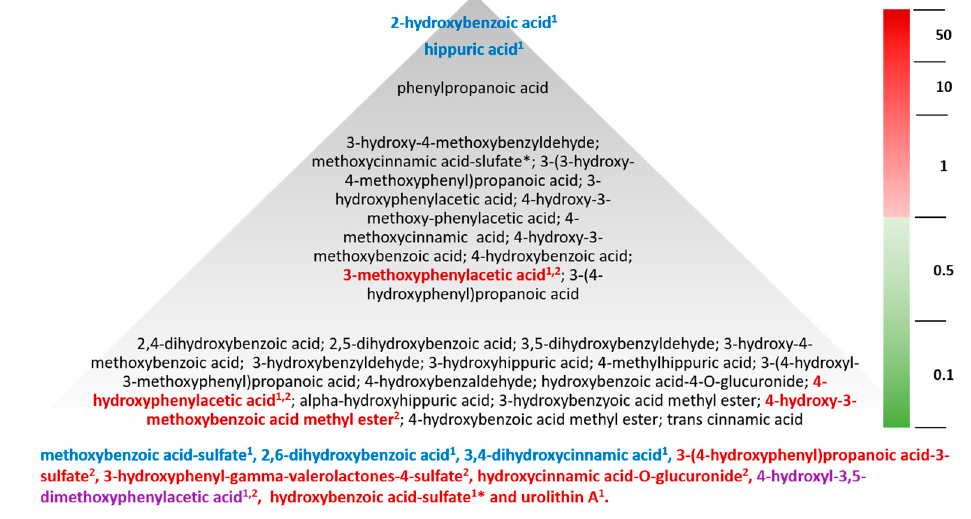
Figure 6. Abundance of human metabolites following consumption of blueberries and strawberries. Values reflect maximum concentration reported in a single serum/plasma sample within the blueberry [4] or strawberry intervention dataset. Bold, metabolites found to change significantly; blue, metabolites changing significantly ( p < 0.05) following feeding with blueberry; red, metabolites changing significantly ( p < 0.05) following feeding with strawberry; purple, metabolites changing significantly ( p < 0.05) following feeding with blueberry or strawberry. Superscripts: 1 significant treatment/intervention effect; 2 significant within treatment group effect for change relative to baseline concentration; * unknown isomeric configuration as a result of co-eluting peaks or lack of reference standard.